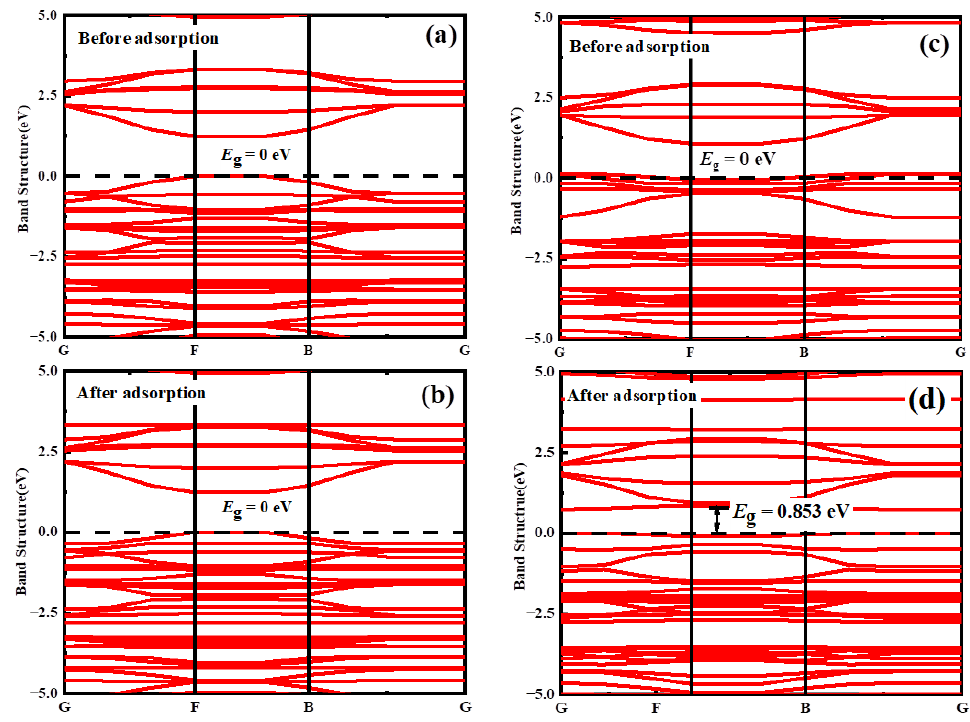
Figure 7. Band structures of different adsorption systems, ( a,b ) CH 2 O@PdPc and ( c.d ) CH 2 O@RuPc.